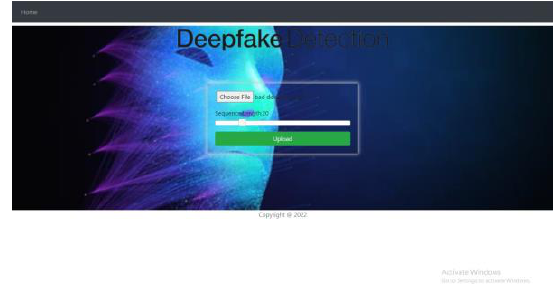
Fig. 7. GUI for video